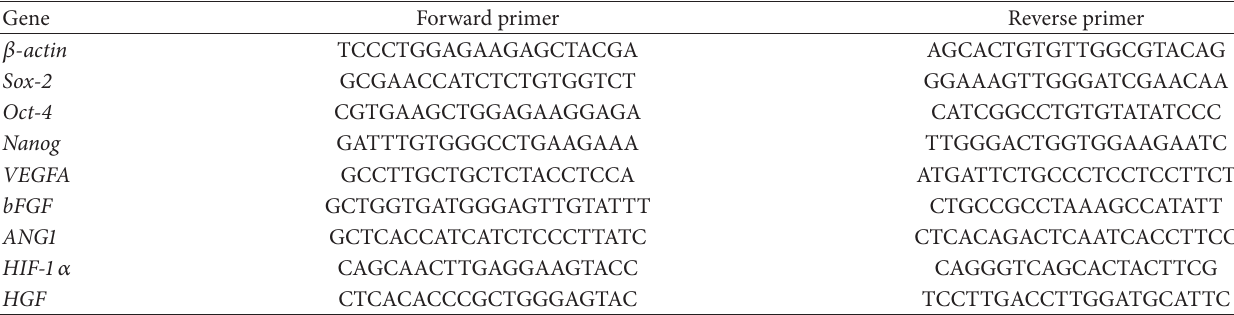
Table 1: Quantitative PCR primers used in this